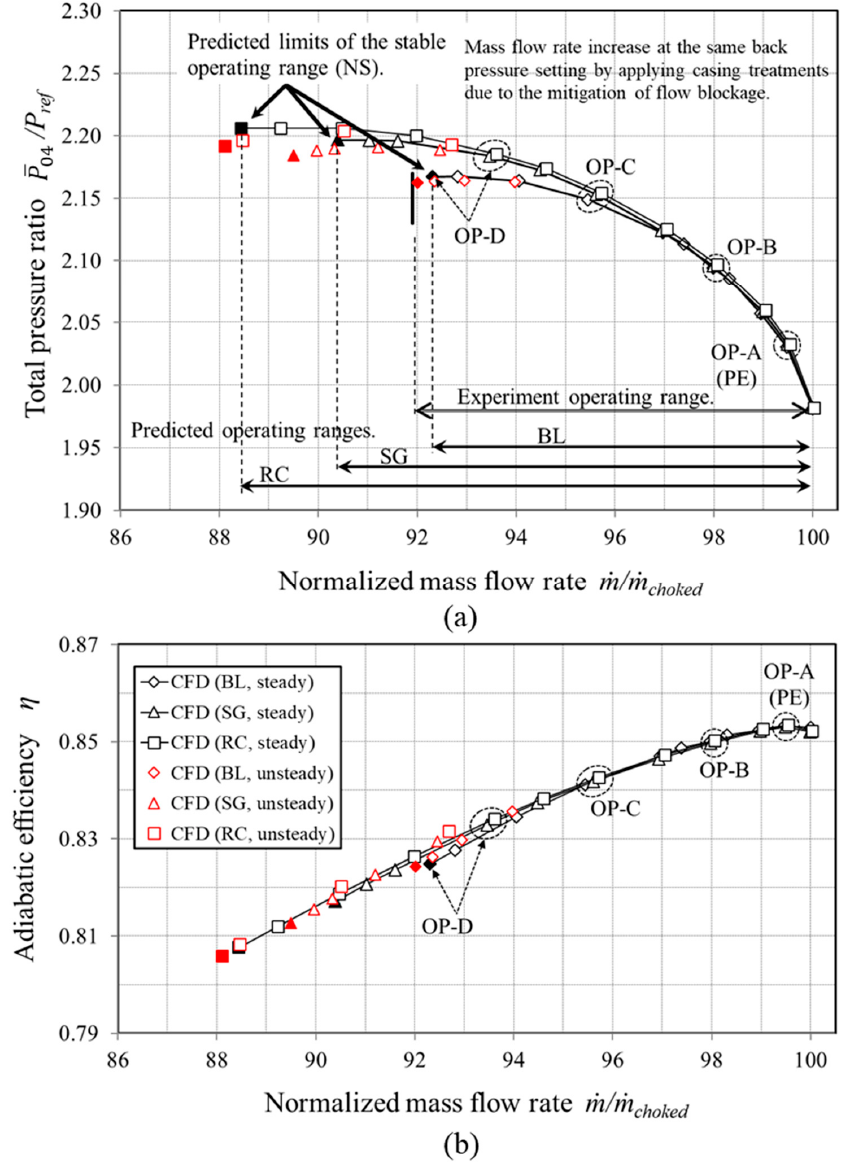
Figure 8. Overall compressor performance characteristics showing the impact of the investigated casing treatments. ( a ) Total pressure ratio across the rotor; ( b ) adiabatic